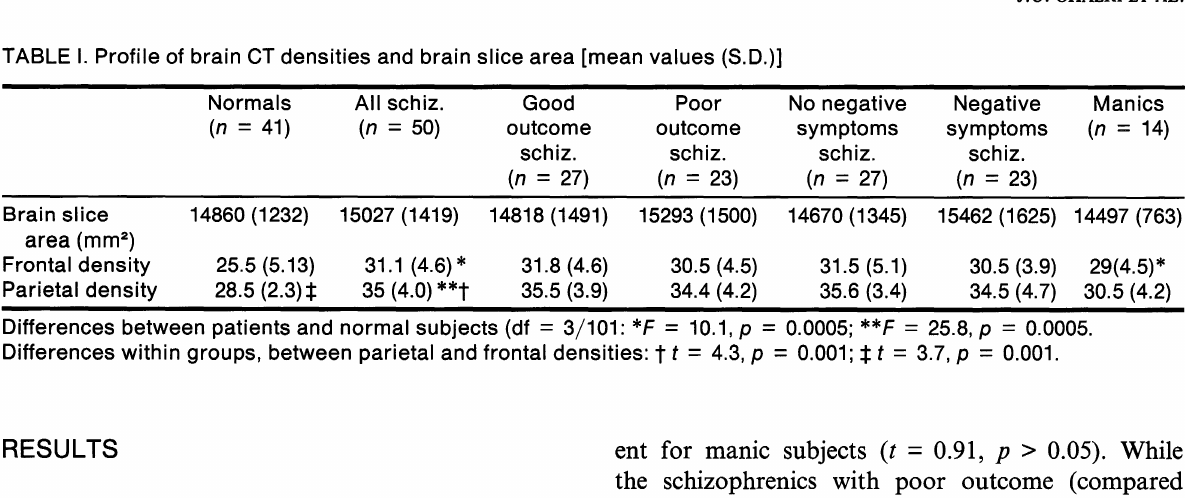
Differences between patients and normal subjects (df Differences within groups, between parietal and frontal densities: t t